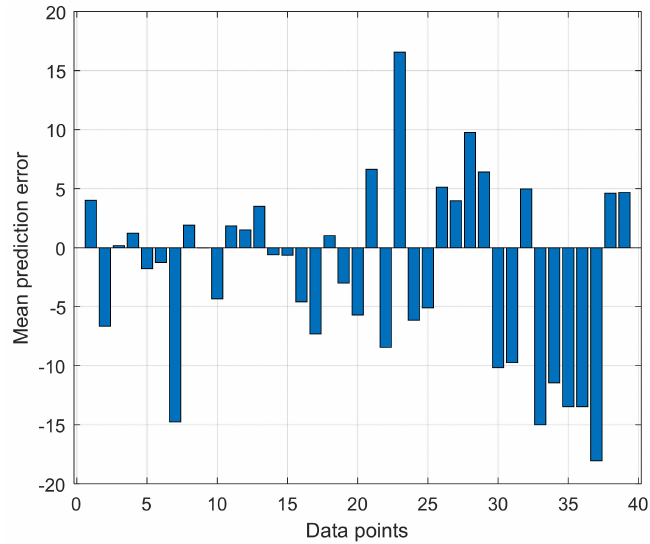
Figure 20. Mean prediction error statistics along with Data points in site